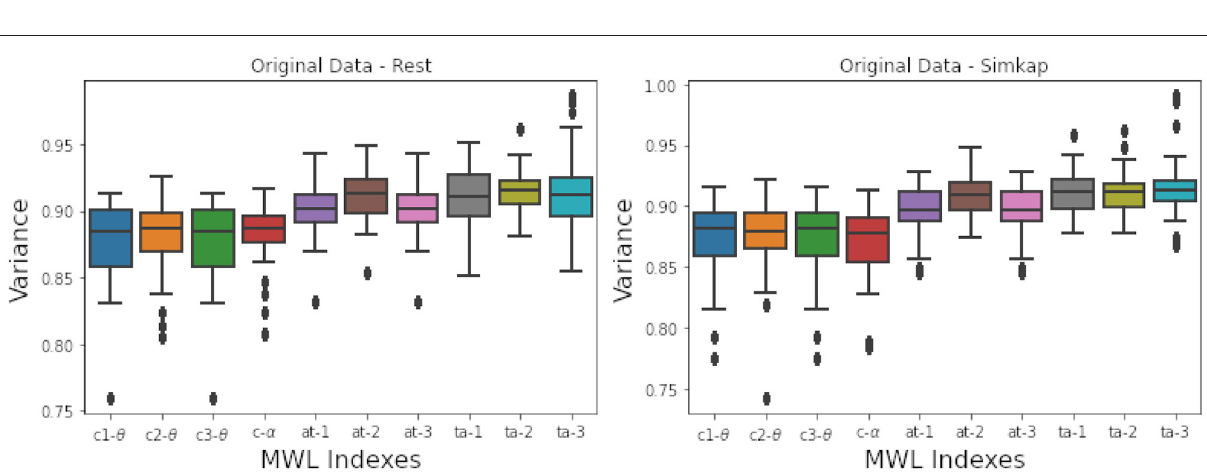
FIGURE 5 | Variance of spectral entropy associated the original data - Left (“Rest” state), Right (“Simkap” state). From the figure it can be seen a small interquartile range Q1- Q3 is small.